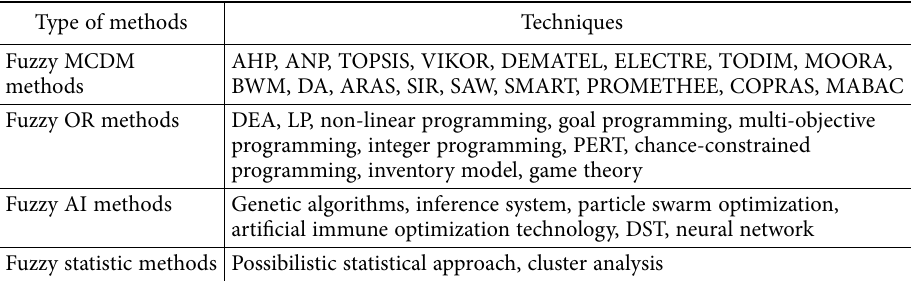
Figure 4. Distribution of the types of fuzzy methodologies Table 6. Techniques included in each type of